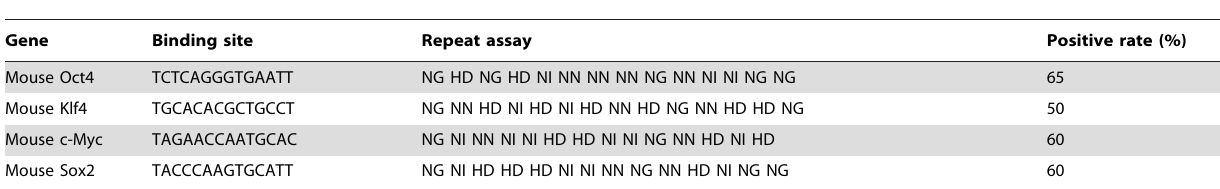
Table 5. TALE-TF constructs.